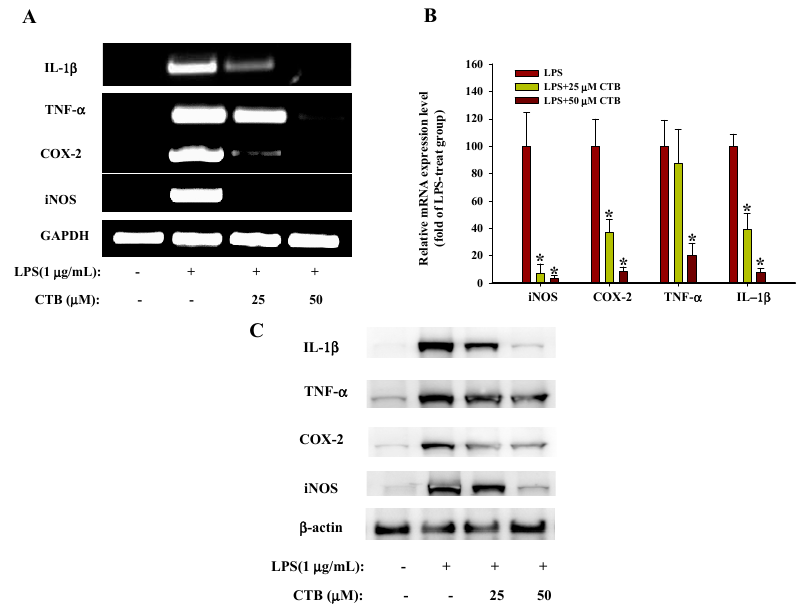
Figure 3. Effects of CTB on inducible nitric oxide synthase (iNOS), cyclooxygenase-2 (COX-2), tumor necrosis factor α (TNF- α ), and interleukin-1 β (IL-1 β ) expression in LPS-treated RAW264.7 cells. RAW264.7 cells were pre-treated with different concentrations of CTB (25, 50 µM) for 30 min before treatment with 1 µg/mL LPS for 6 h. iNOS, TNF- α , COX-2, and IL-1 β mRNA expression was measured by semi-quantitative PCR ( A ) and real-time PCR ( B ); iNOS, TNF- α , COX-2, and IL-1 β protein expression was measured by western blot ( C ). A typical experiment from three independent experiments is shown. * p < 0.05 compared to LPS treatment alone.